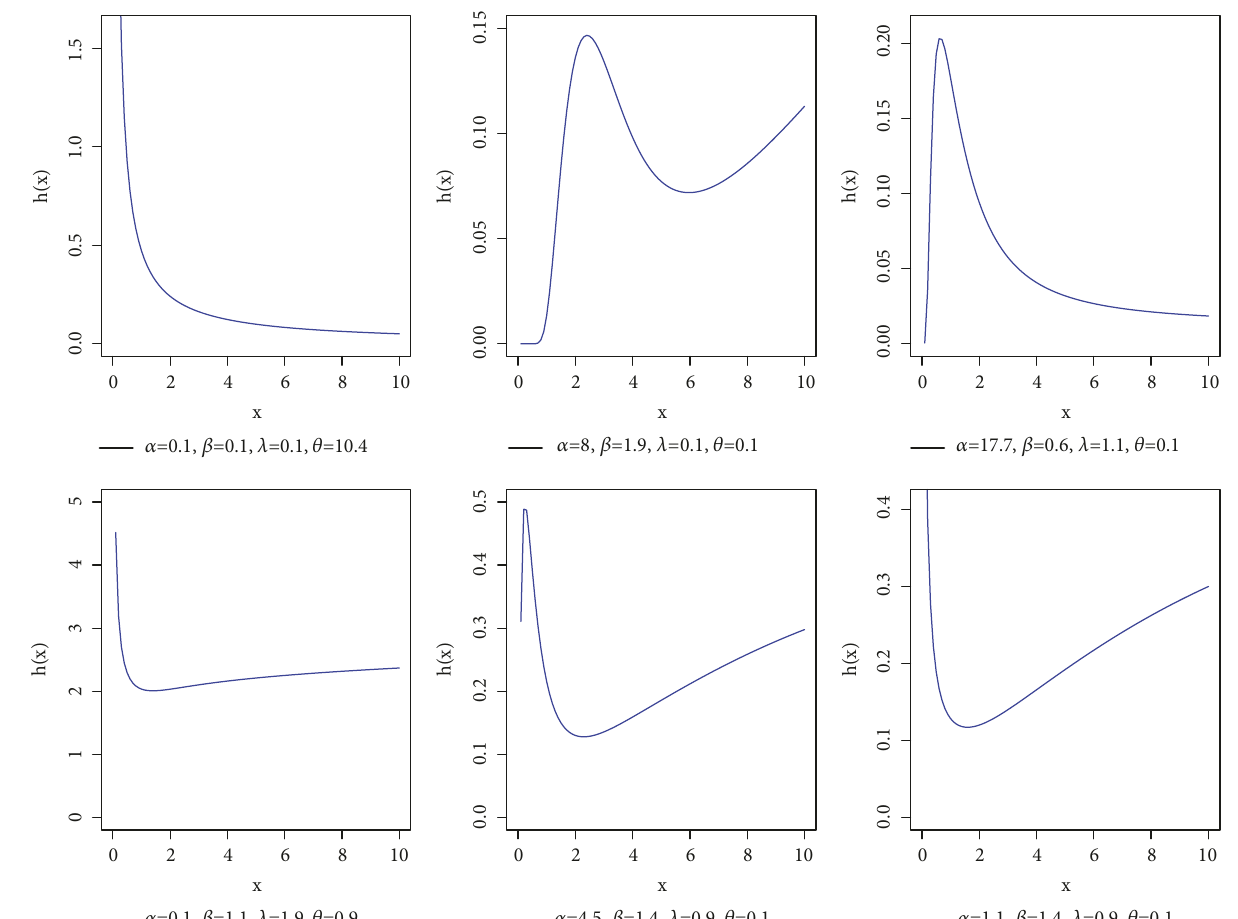
Figure 4: Plots of the EOFW distribution hazard rate